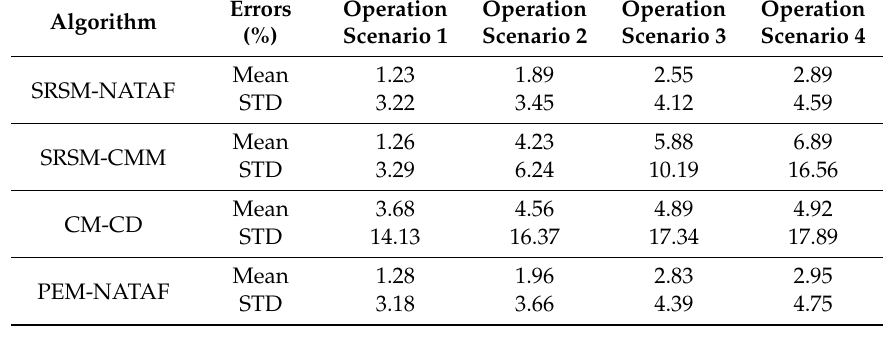
Table 6. The errors of the mean and standard deviation values of the active power losses from the AC grid in the four different operational scenarios examined.